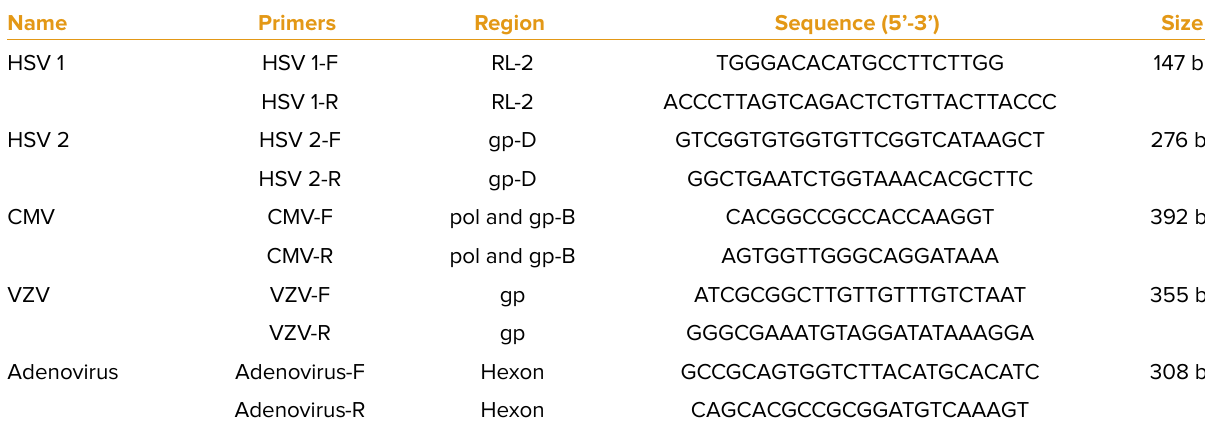
Table 1. Details of primers for the five selected targets for the multiplex PCR